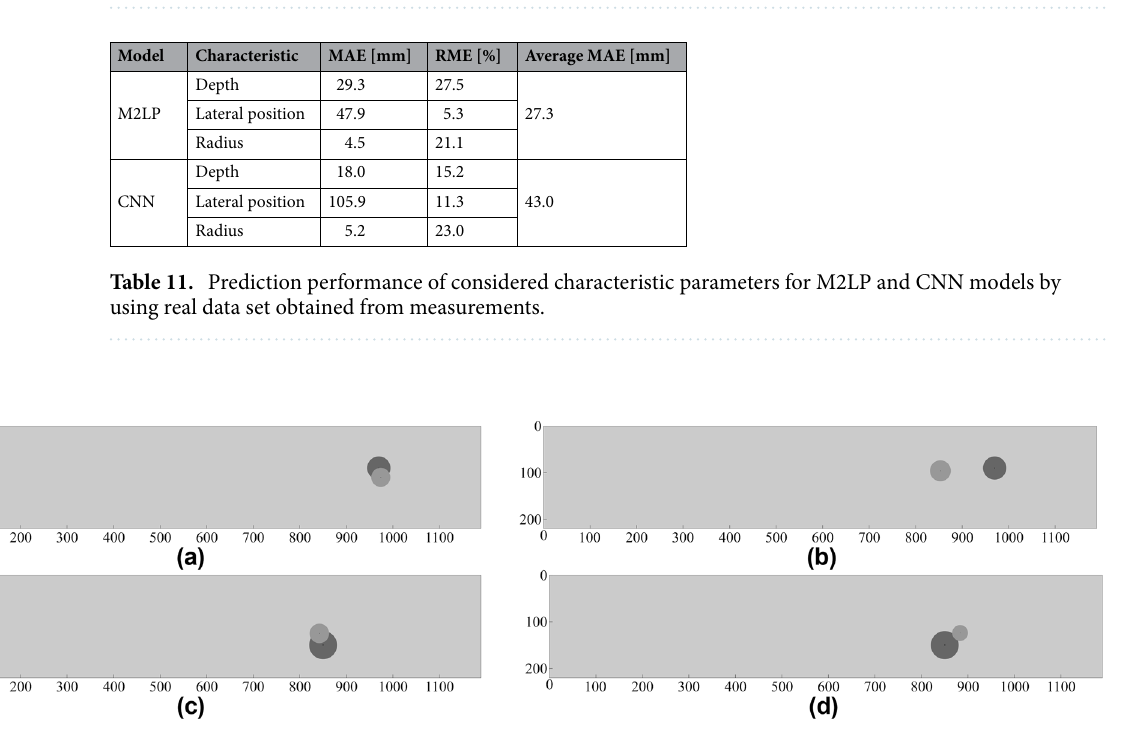
Figure 15. Raw and pre-processed B-scan data with their extracted hyperbolic patterns for selected sample concerning the following test scenario which corresponds to D = 750 mm, P = 90 mm, and R = 15 mm: ( a ) raw B-scan image, ( b ) B-scan image with removed background reflections, ( c ) extracted hyperbolic pattern.